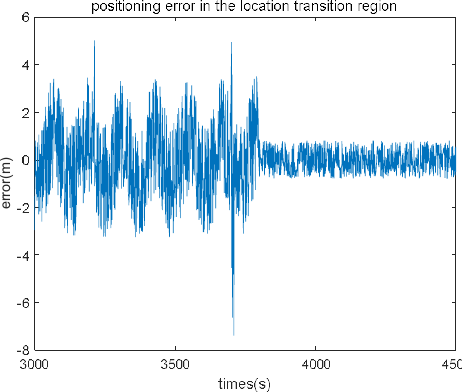
Figure 8. Positioning switching